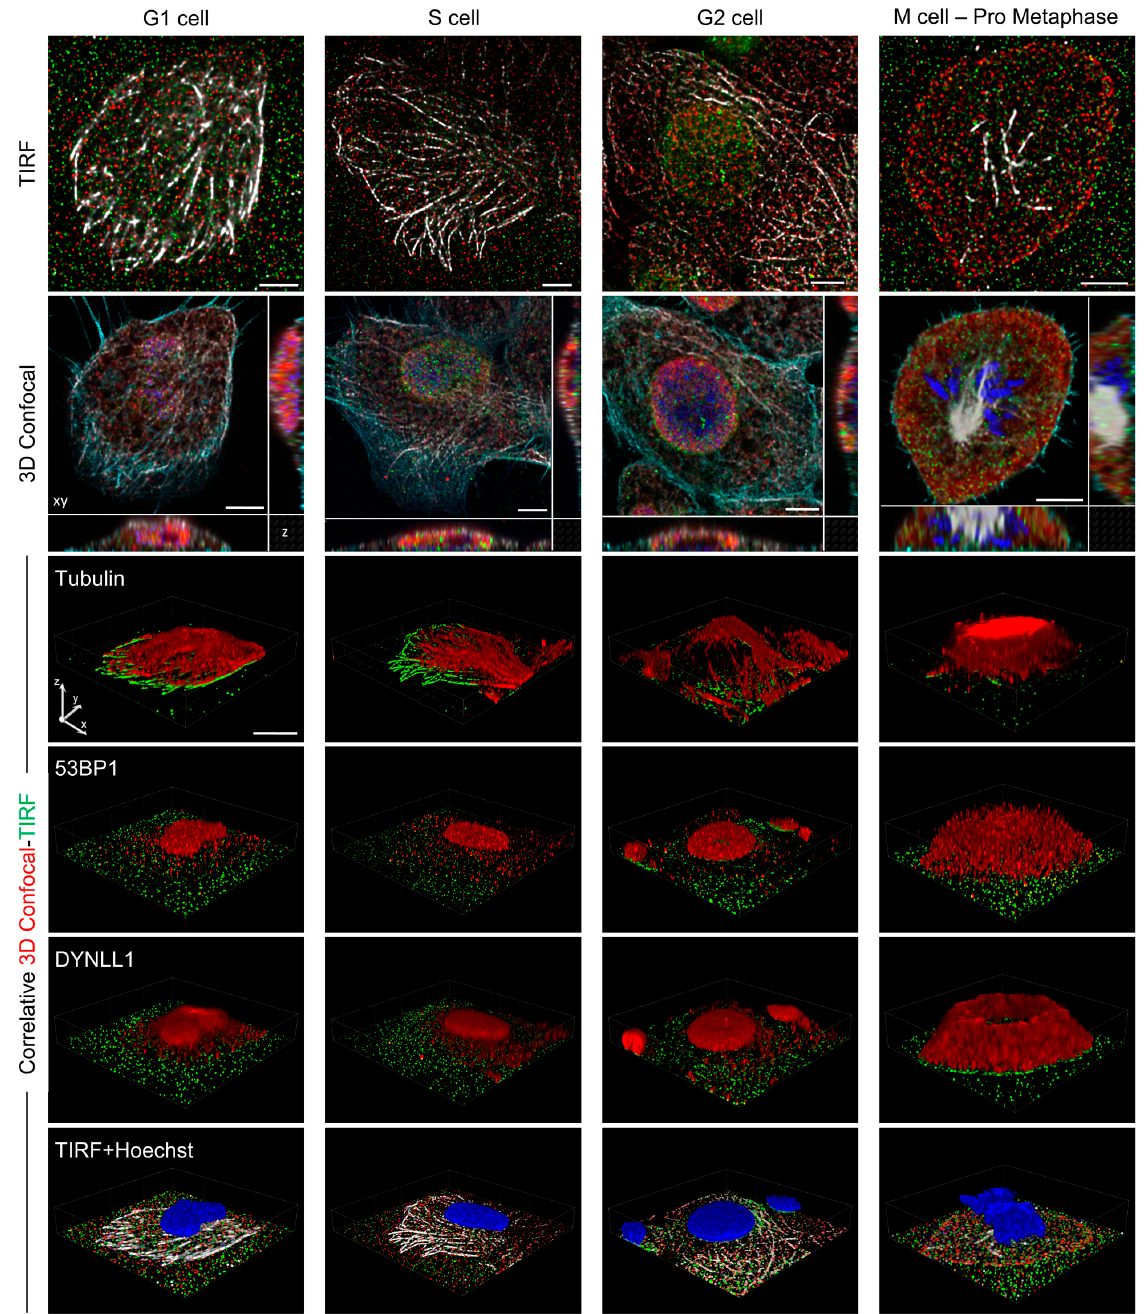
Figure 8. Correlative Confocal-TIRF Analysis on Image-Cytometry re-localized cells. Representative re-localized cells in different cell-cycle phases (G1, S, G2, M) acquired by the correlative Confocal-TIRF protocol described in the text. TIRF images of 53BP1, DynLL1, and Tubulin were first acquired, followed by Confocal Z-Stacks of 53BP1 (Green), DynLL1 (Red), Tubulin (White), Phalloidin (Cyan), and Hoechst (Blue). The TIRF plane is identified in the Z-Stack, aligned, and merged at the corresponding position and then inserted into the Z-stack (3D projections). The rows show (from top to bottom): TIRF images, lateral planes reconstructions of Confocal Z-Stacks (scale bar: 5 µ m), and correlative 3D volume projections (scale bar: 10 µ m) of Tubulin, 53BP1, DynLL1, and Hoechst. Three-dimensional projections show the proteins distribution at the basal membrane and in the cell volume (red: confocal; green: